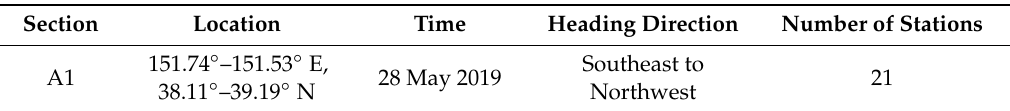
Figure 1. ( a , b ) Daily and ( c ) mean Sea Surface Temperature (SST) gradients (shading in °C/km), Sea Level Anomaly (SLA) (contours in m), and geostrophic currents (vectors in m/s) in the Zone A during the section observation period. Intervals for contour lines are 0.05 m. Black dots are the corresponding observation stations labeled in black. Gray dots are the other stations. Table 1. Details of Section A1–A4, the number of stations means the number of Moving Vessel Profiler (MVP) stations set for each section.